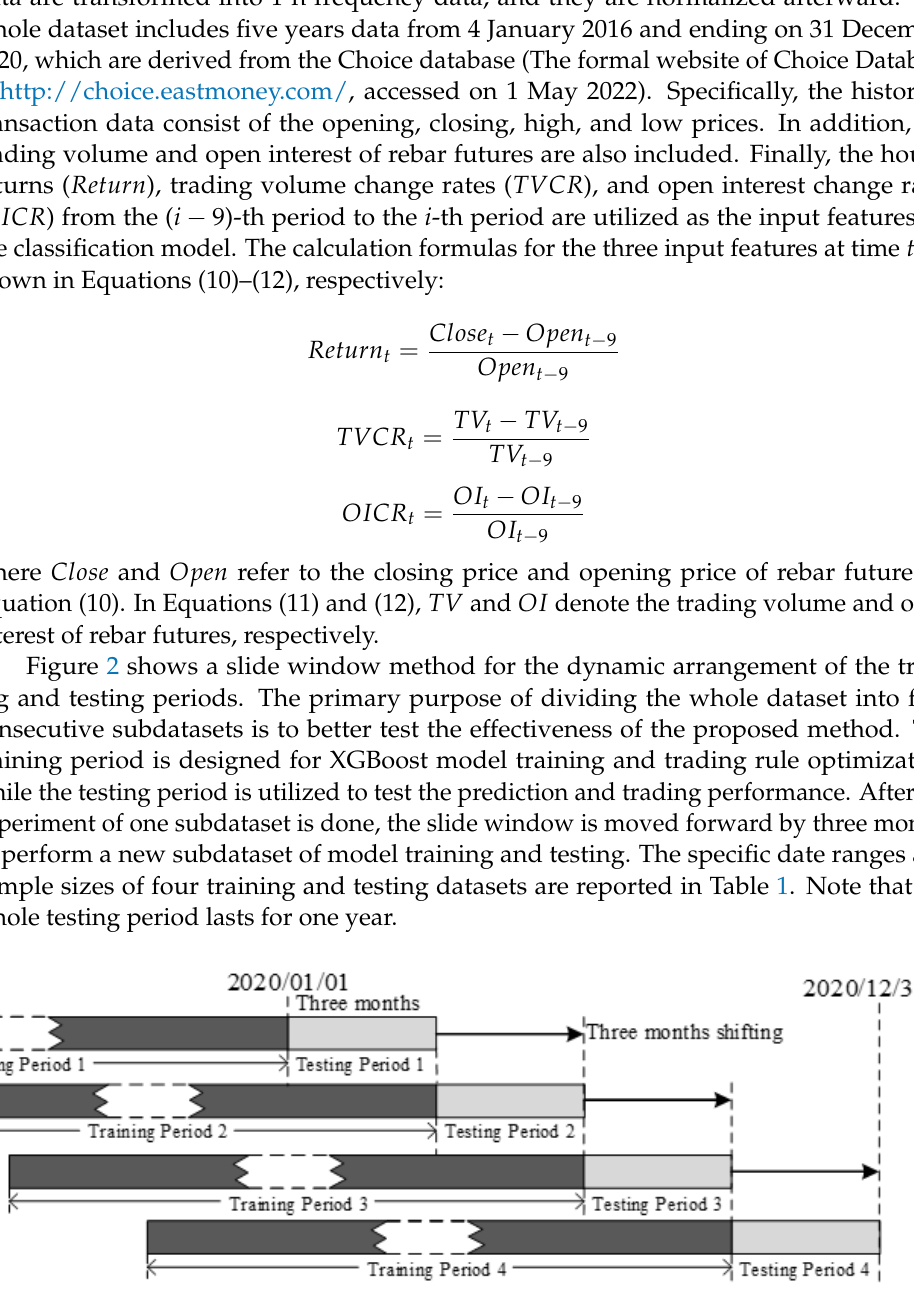
Figure 2. The slide window method for the dynamic arrangement of the training and testing pe- riods. Table 1. The dataset design for the experiments.